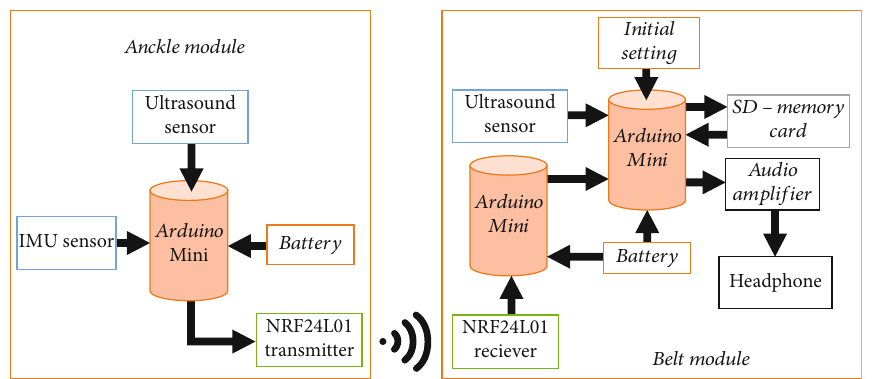
Figure 3: Architecture for modular assistive device for visually impaired people.